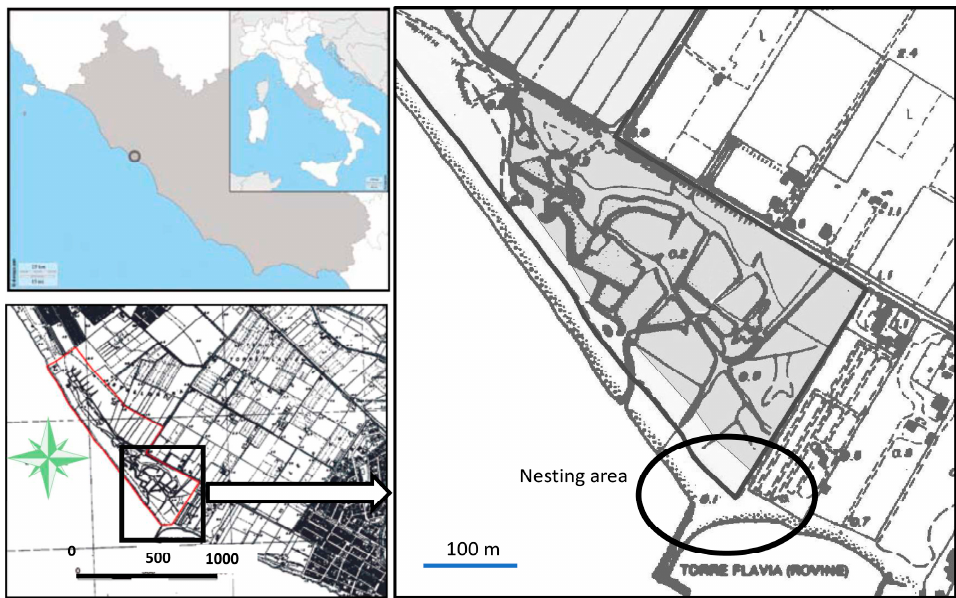
Figure 1. Map of the study area. Top left: geographical location at regional and national levels. Bottom left: “Palude di Torre Flavia” Special Protection Area (SPA; Rome, central Italy; in red color: perimeter of the protected area; source: Regione Lazio—Technical Map having a grid of 1 km × 1 km-wide units). Right: southern sector of the SPA with the nesting sites